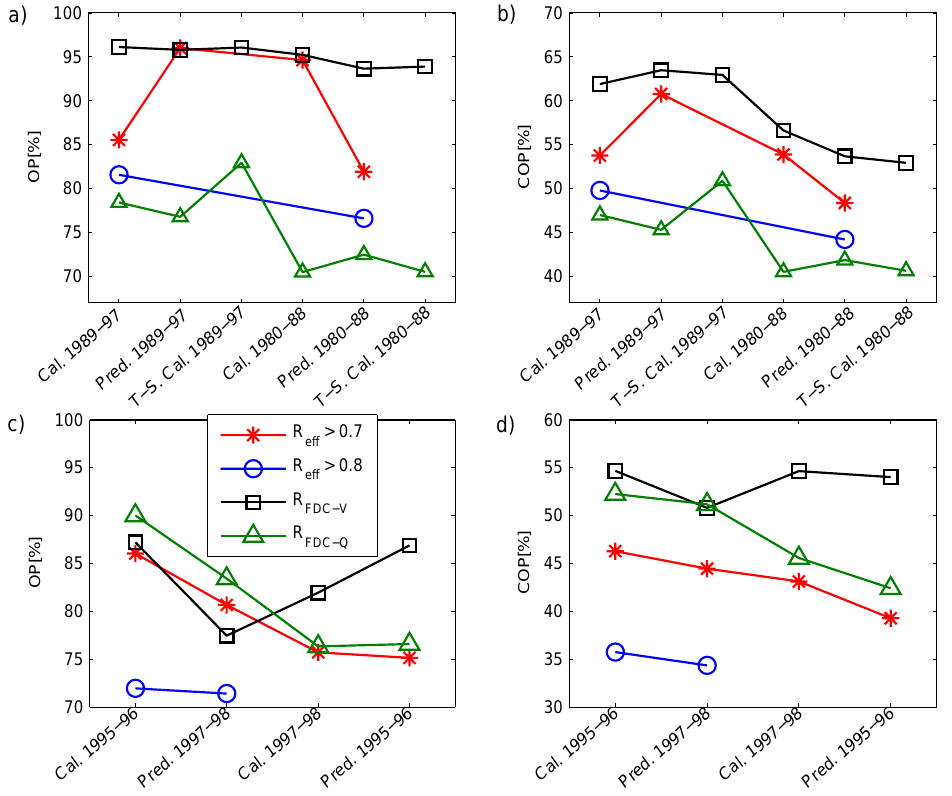
Fig. 11. Percentage of time that the simulated and observed uncertain discharges overlap (OP) and the combined overlap percentage (COP) for the calibration (Cal.), time-shift calibration (T-S. Cal.) and prediction (Pred.) using WASMOD in the Paso La Ceiba catchment (a–b) and calibration and prediction using Dynamic TOPMODEL in the Brue catchment (c–d) .